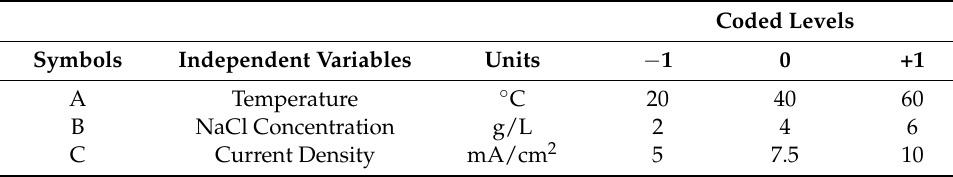
Table 1. The levels and range of independent variables chosen for EO.